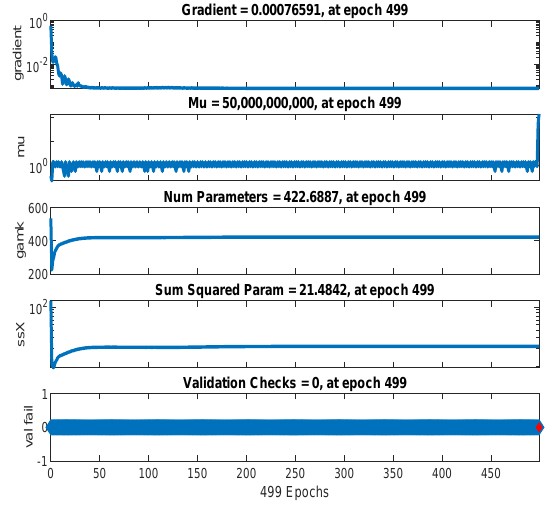
Figure 18. The neural network training